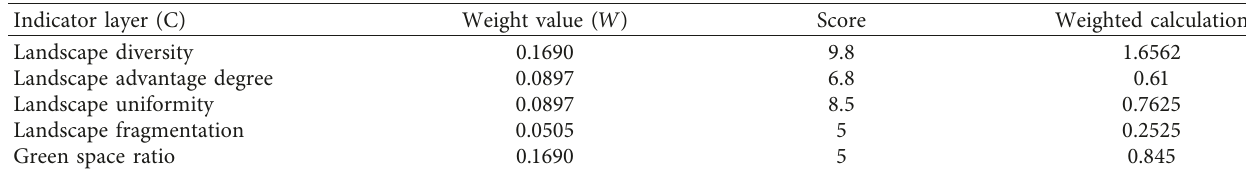
Table 12: G335 Chongli-Chicheng section ecological landscape index weighted calculation results.